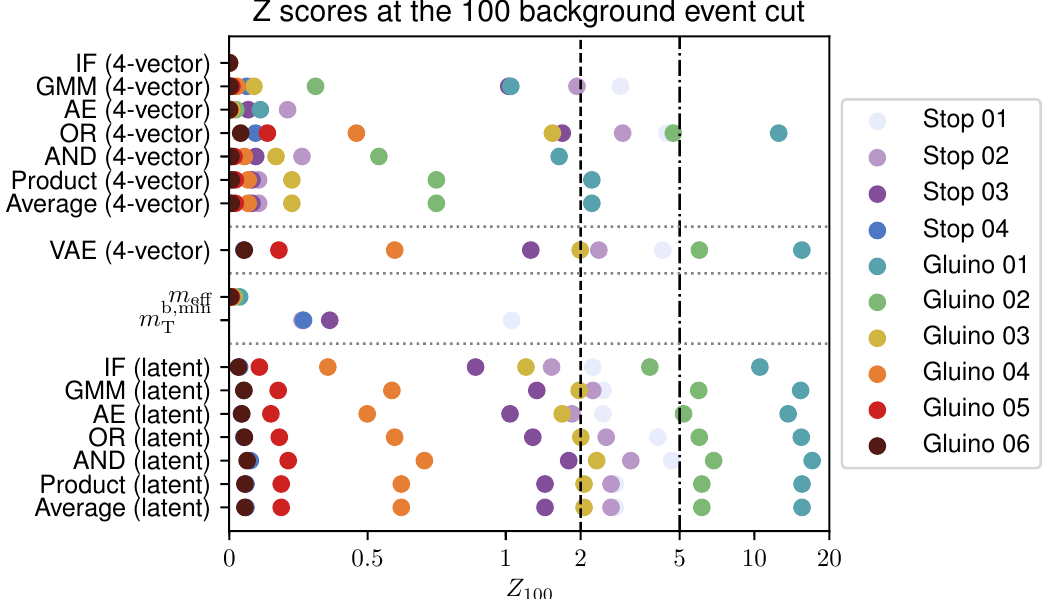
Figure 11 . Z 100 yielded from various algorithms applied to 4-vector components and latent space representations. See table 1 for the signal definitions, and table 3 for the definitions of the algo- rithms.